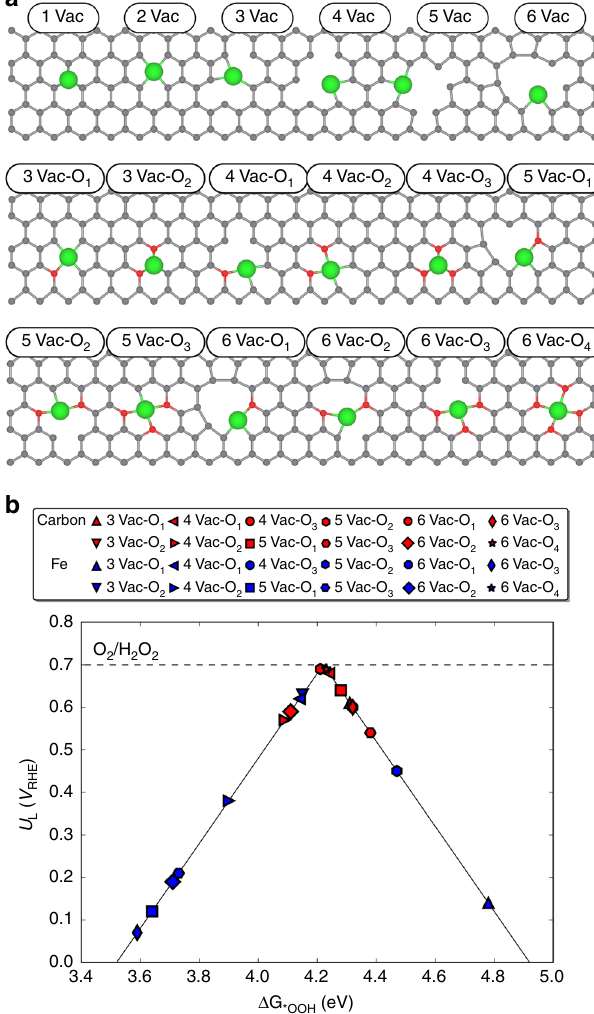
Fig. 4 DFT calculations of the ORR activity and selectivity on different motifs. a All examined con fi gurations for single Fe atom coordinated in two- dimensional carbon material with and without O species. We used the most stable surface coverage as a reference (Supplementary Figs. 29 – 31). Green, red, and gray colors denote Fe, O (or N), and C atoms, respectively. b The calculated ORR activity volcano plot for 2e – pathway to H 2 O 2 . Red and blue symbols indicate *OOH adsorption at C and Fe, respectively. The equilibrium potential of O 2 /H 2 O 2 is shown as a black dashed line. Some of the points are not shown in the volcano plot since their binding energies are out of the